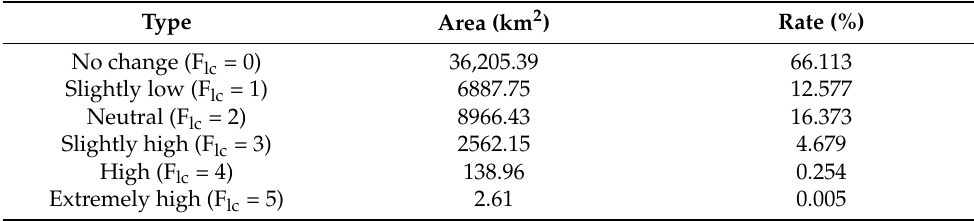
Table 4. Proportion of area in areas with different frequencies of land-use change.